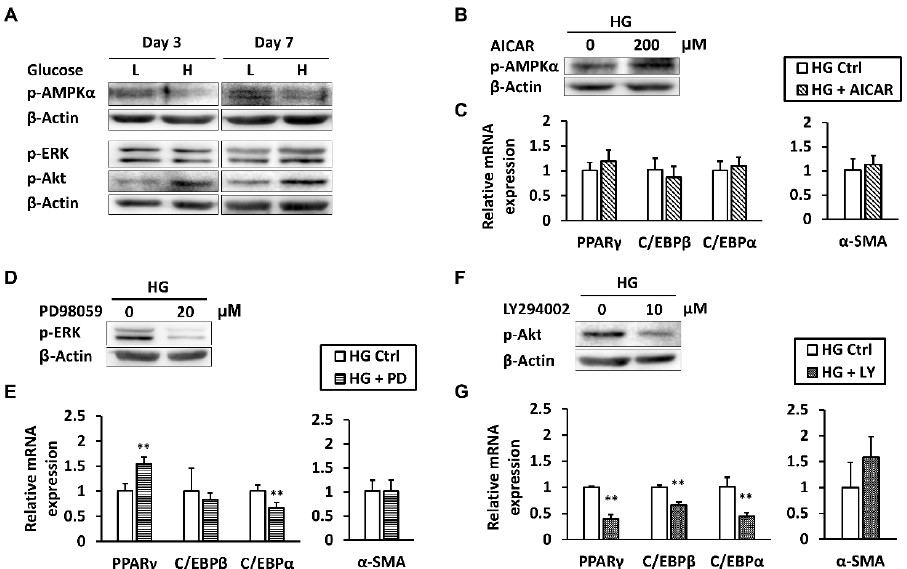
Figure 4. ERK and Akt signaling play opposing roles in regulating PPAR γ expression. ( A ) Protein levels of p-AMPK α , p-ERK, and p-Akt in tenocytes cultured in low- or high-glucose conditions were measured. At day 3, after tenocytes in high-glucose conditions were treated with AICAR, PD98059, or LY294002 for 6 h; ( B ) p-AMPK α ; ( D ) p-ERK; and ( F ) p-Akt protein levels were examined; and ( C , E , G ) the mRNA expression levels of adipogenic markers and α -SMA that were altered by high glucose were analyzed, respectively. Data are presented as the mean ± SD ( n = 4). Statistical significance is shown as ** p <0.01 compared to the DMSO-treated control group.